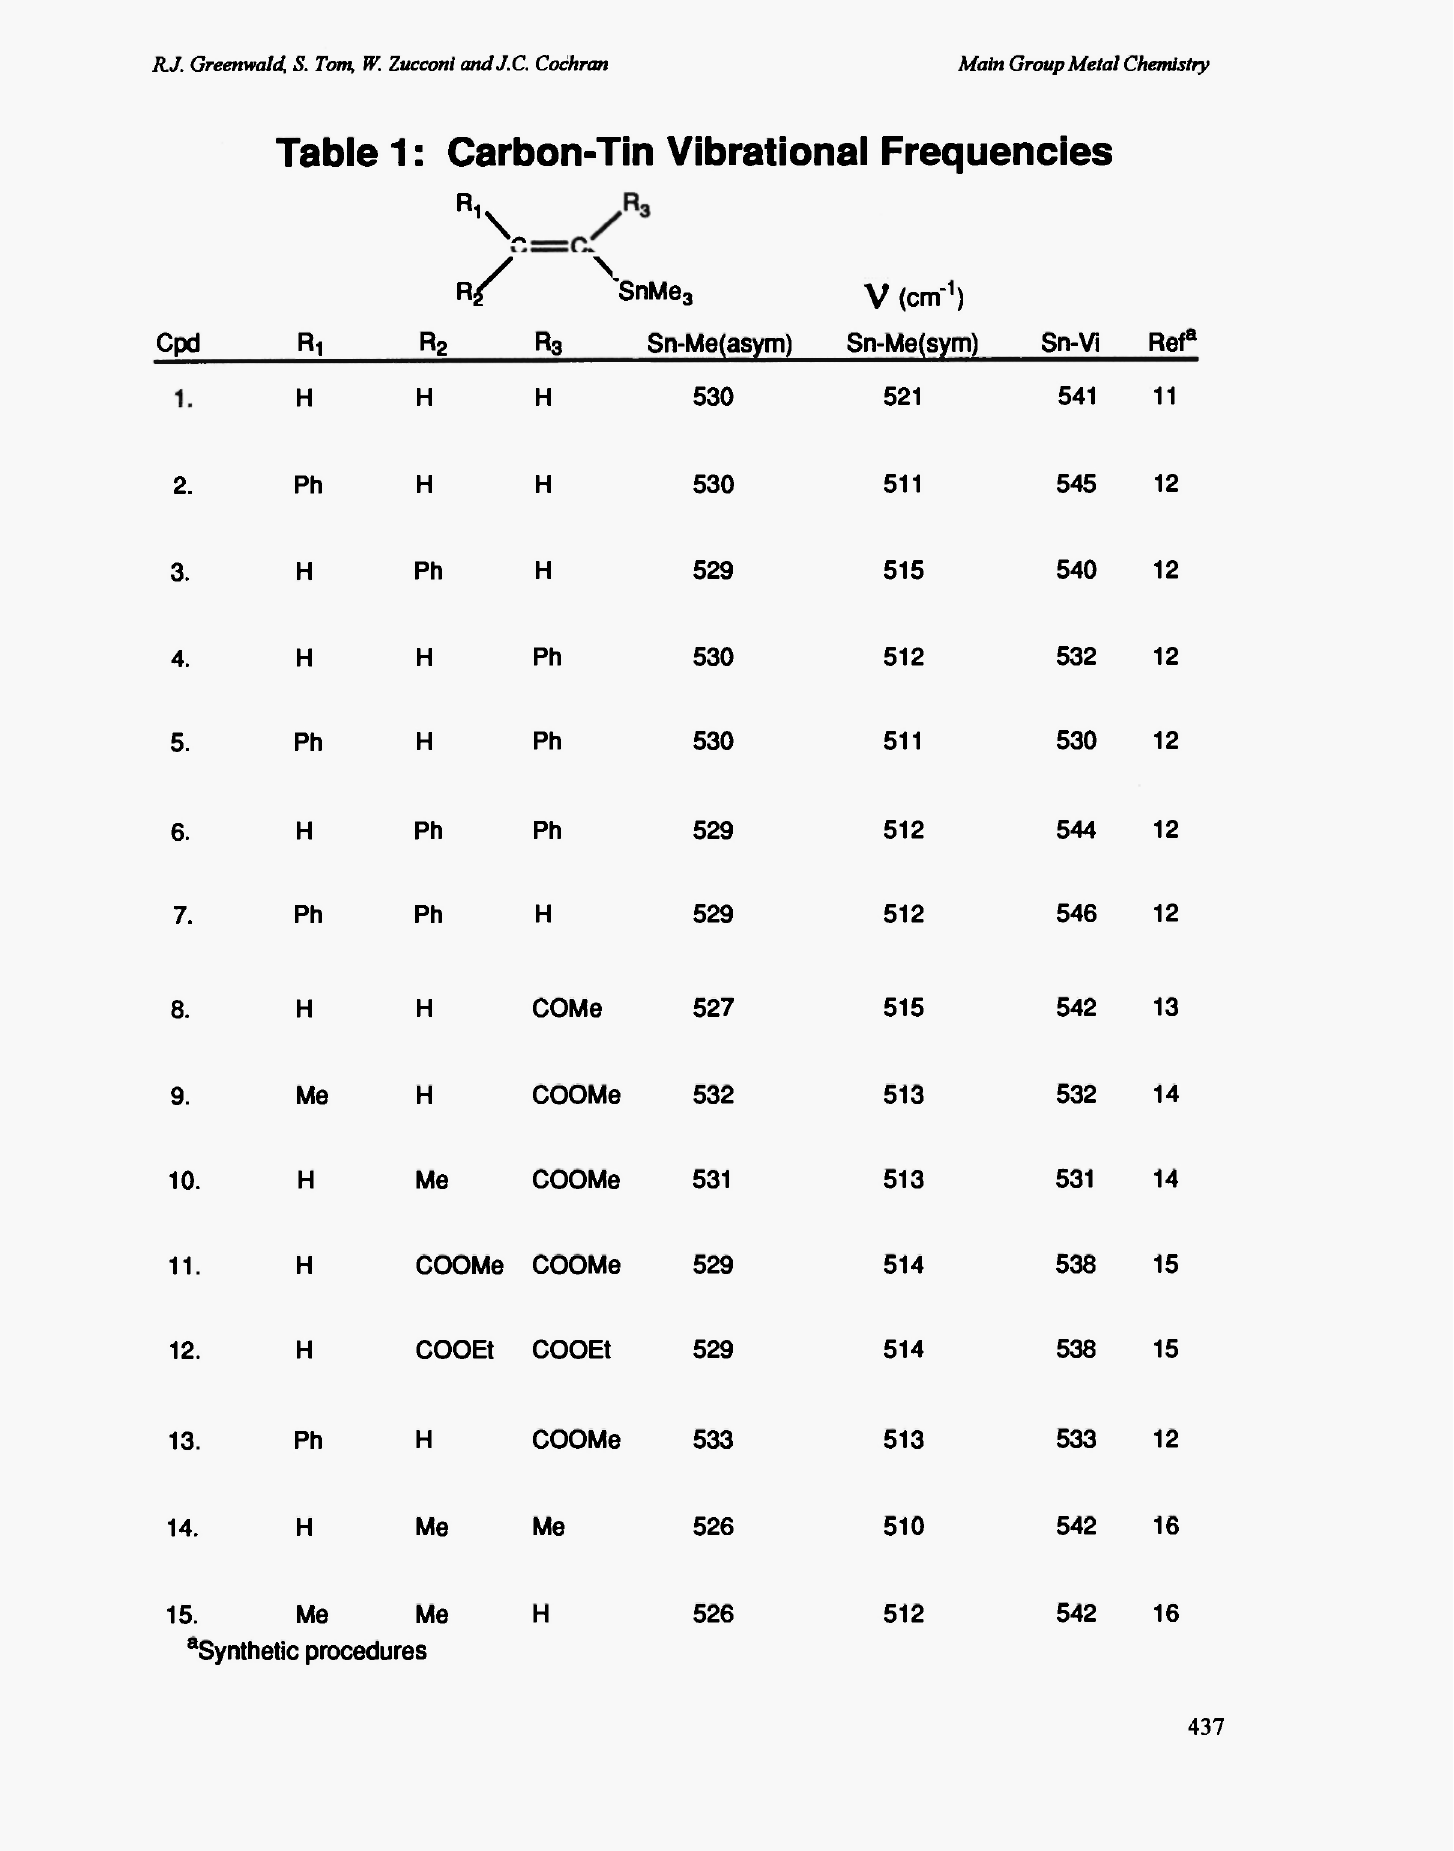
Table 1: Carbon-Tin Vibrational